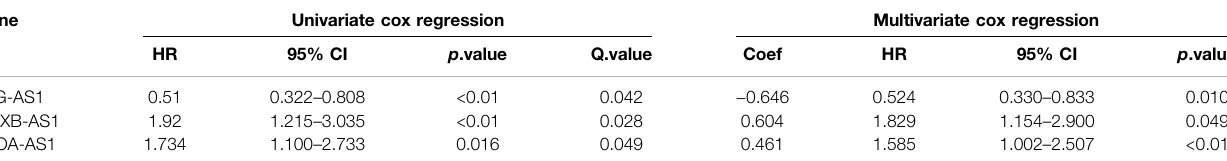
TABLE 3 | Results of univariate and multivariate Cox regression model. Down regulation was the reference state. p -values were adjusted by the Benjamini-Hochberg procedure and called Q.values. Abbreviation: HR, Hazard ratio; 95% CI, 95% con fi dence intervals; Coef, multivariate Cox regression coef fi cient. Gene Univariate cox regression Multivariate cox regression